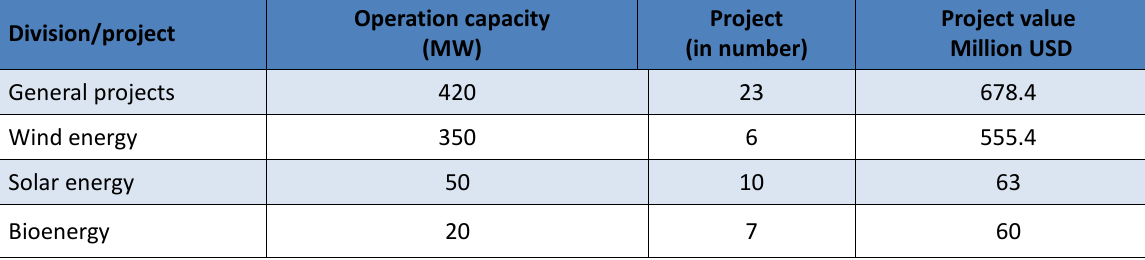
Table 6 Investment in green energy for 2018-2020 * Division/project